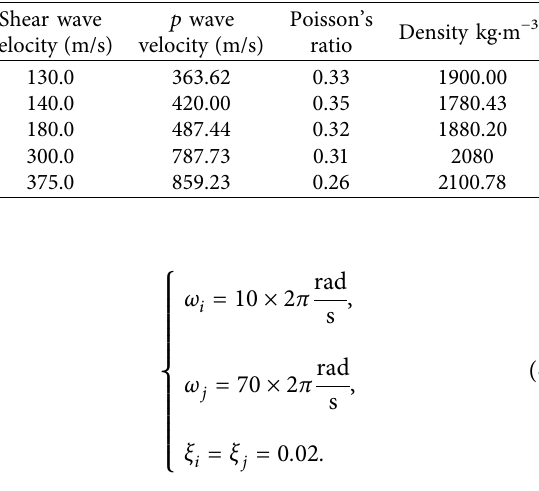
Figure 15: Finite-element (FE) model. Table 4: Physical and mechanical soil